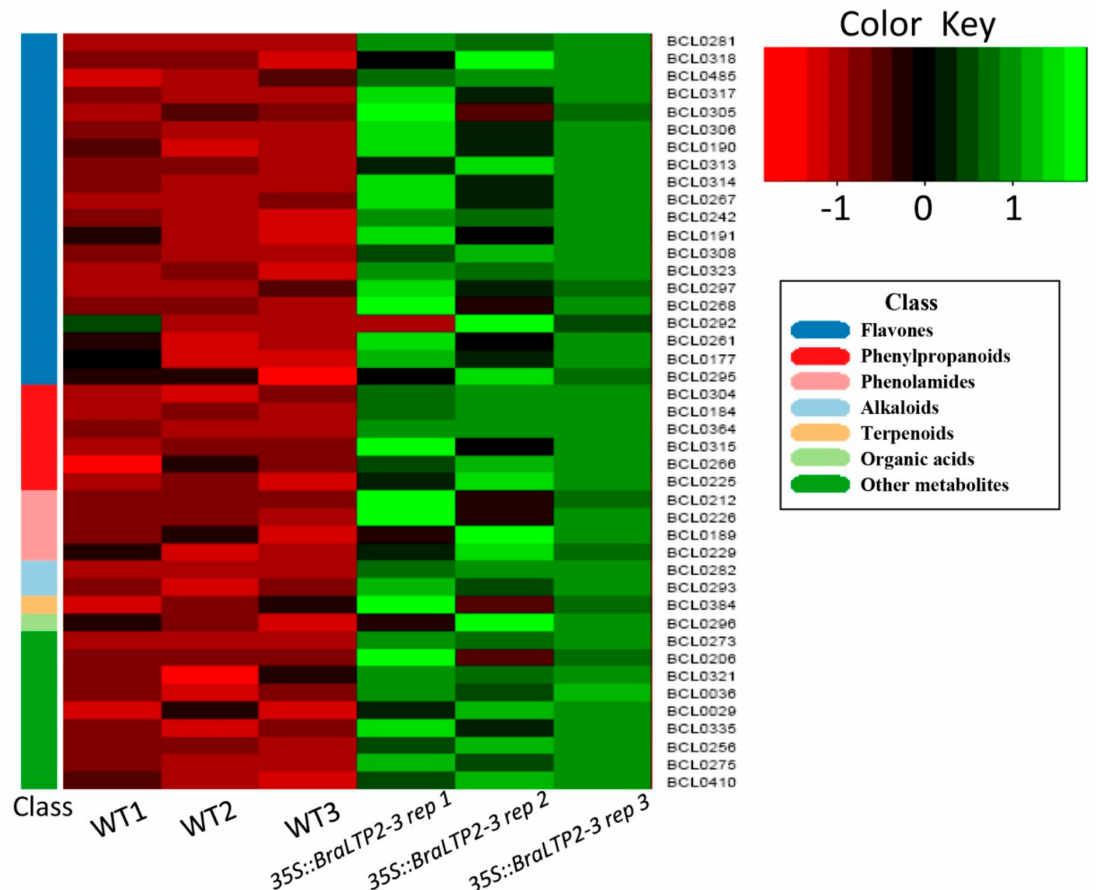
Figure 6. Differential classes of up-regulated secondary metabolites clustering heatmap. Seven classes of up-regulated secondary metabolites between 35S::BraLTP2 -3 rep 1–3 group and WT1–3 group in the clustering heatmap. The abscissa corresponds to the group number, the right ordinate corresponds to the secondary metabolites number, and the left ordinate of different color modules corresponds to the seven classes of metabolites. The color indicates abundance of changes in secondary metabolites from − 1 to 1. Green corresponds to a higher correlation, the intensity of green is an indication of a higher content of secondary metabolites in the corresponding